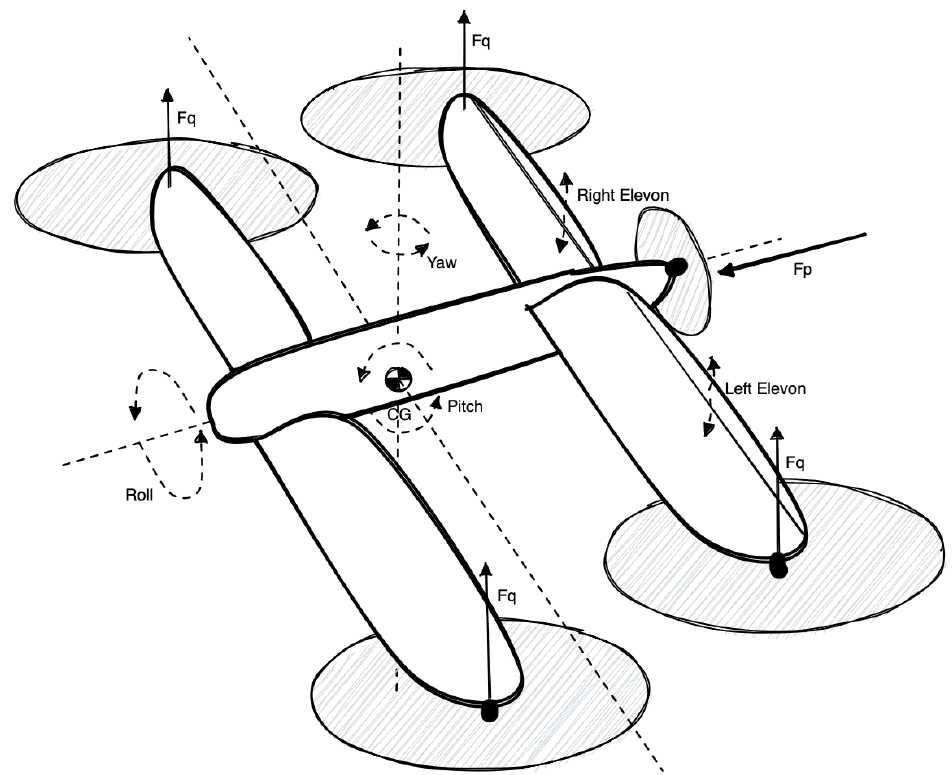
Figure 20. Axes of rotation and control forces produced by the drone’s motors and elevons (at the rear